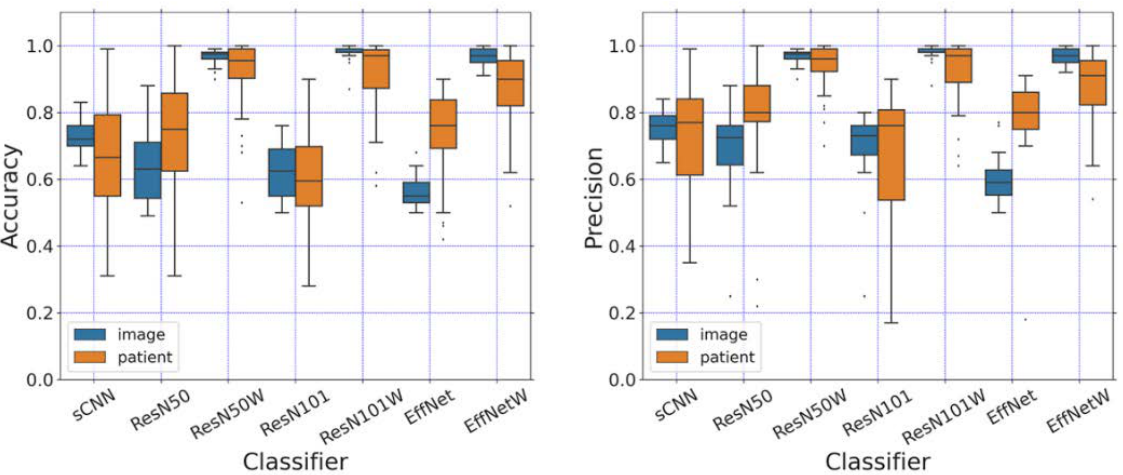
Figure 5. Accuracy and loss of each model on the training and validation dataset.